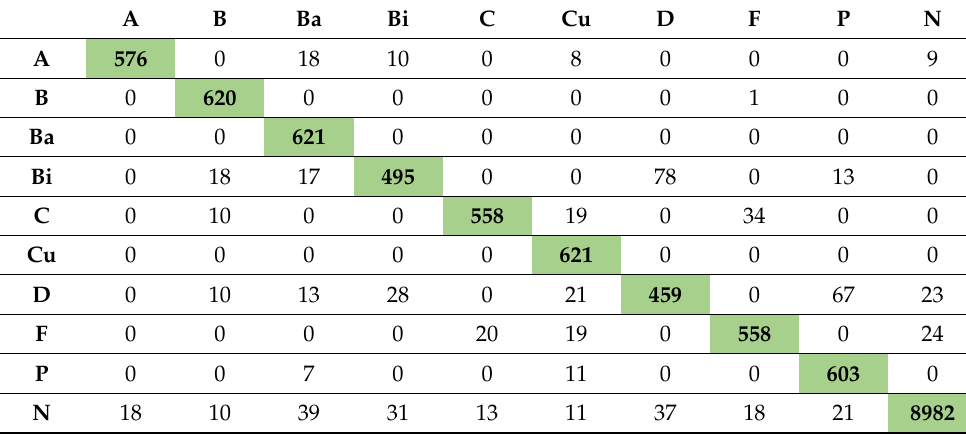
Table 8. One-fold confusion matrix for RNN 10-class